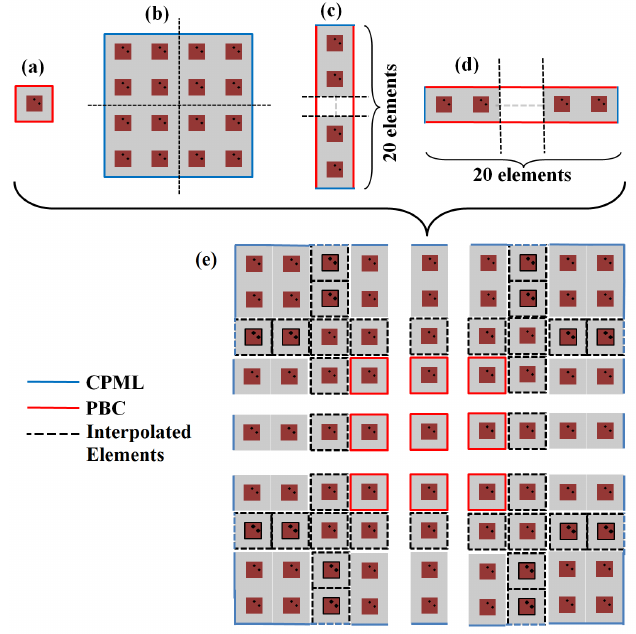
Figure 16. Illustration of the finite array antenna simulation. ( a ) Infinite-by-infinite array; ( b ) small finite-by-finite array; ( c ) finite-by-infinite array; ( d ) infinite-by-finite array; and ( e ) large finite-by-finite array computation using ( a ), ( b ), ( c ), and ( d